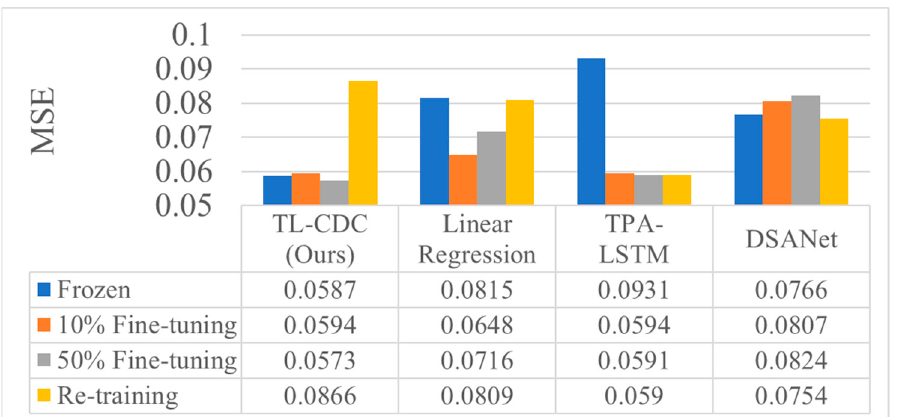
Figure 18. Comparison of TL-CDC and other time series models for predicting the course develop- ment of target disease under k = 2.